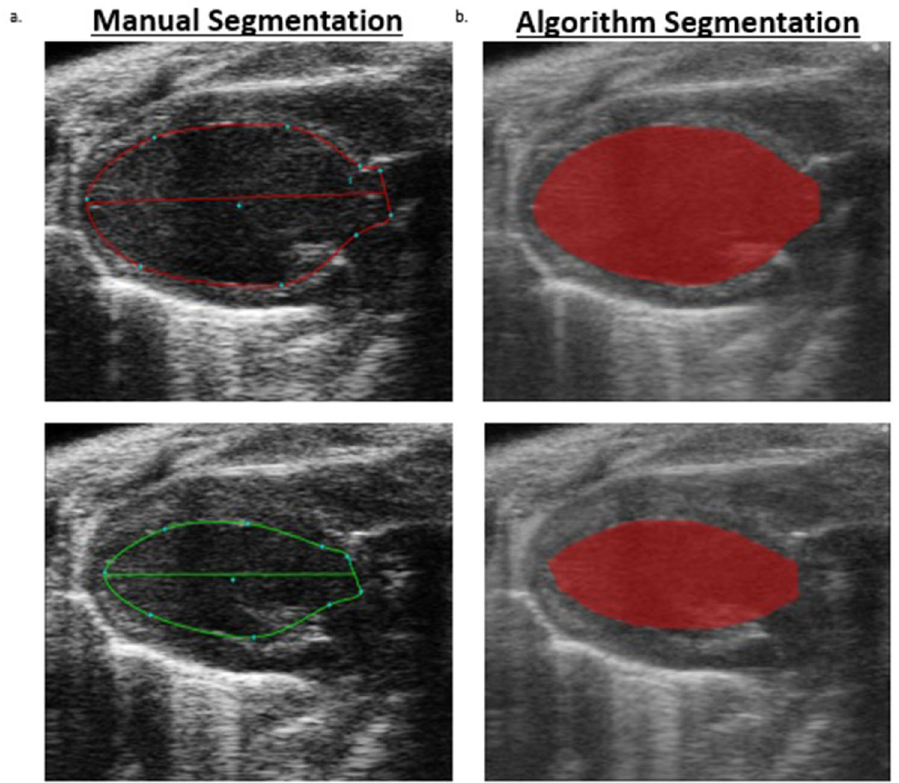
Figure 3. B-mode ROI’s: 2-dimensional left ventricle long axis B-mode echocardiograms from C57BL/6 mice. Visual comparison of manually segmented ROI (left) vs. ROI generated from the semi-automated segmentation algorithm of the same images (right). ( a ) shows a representative baseline long axis LV B-mode echocardiogram from a C57BL/6 mouse that was traced manually (top is the LV in end-diastole, bottom is the LV in end-systole). ( b ) Shows the same baseline LV B-mode echocardiogram, but with segmentation conducted using the semi- automated algorithm for analysis (top is LV in end-diastole, bottom is LV in